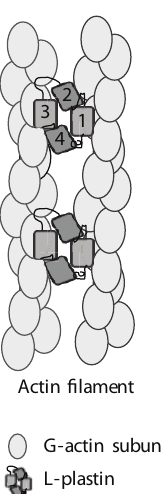
Figure 2: LPL folds into a compact structure that bundles actin filaments. Numbers indicate each CH domain. Based on available experimental data, it has been proposed that ABD2 binds to a polymerizing actin filament such that the nucleotide-binding cleft adopts a more “closed” position, thus stabilizing the filament. Bind- ing of ABD1 to an adjacent filament cross-links F-actin into tight